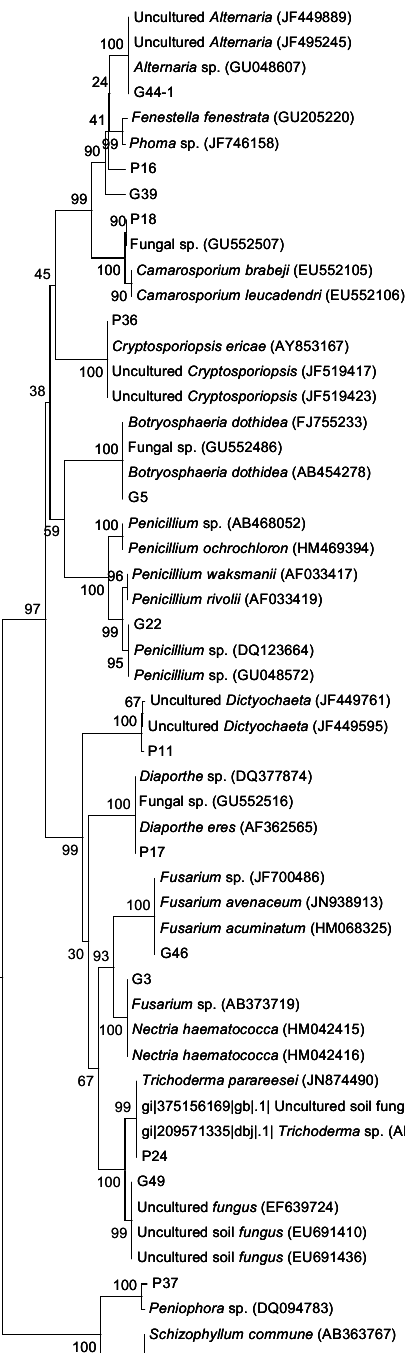
Figure 1. A 28S rDNA sequence-based phylogenetic tree constructed using the neighbor-joining method. Scale bar represents 10% estimated sequence divergence. Numbers in the branches indicate bootstrap values (percentages for 1000